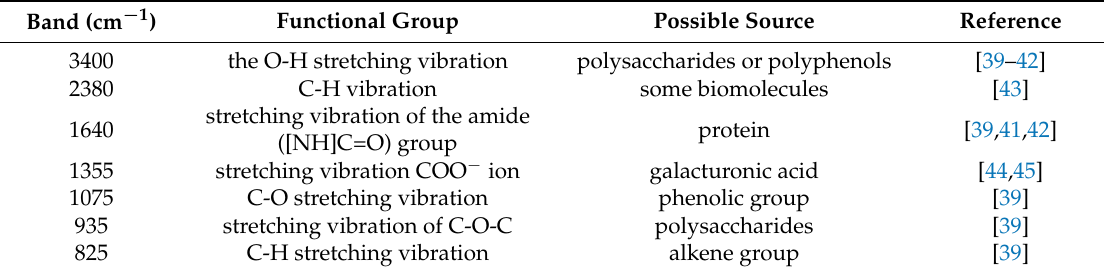
Table 2. Functional groups identified by FTIR and their potential sources.